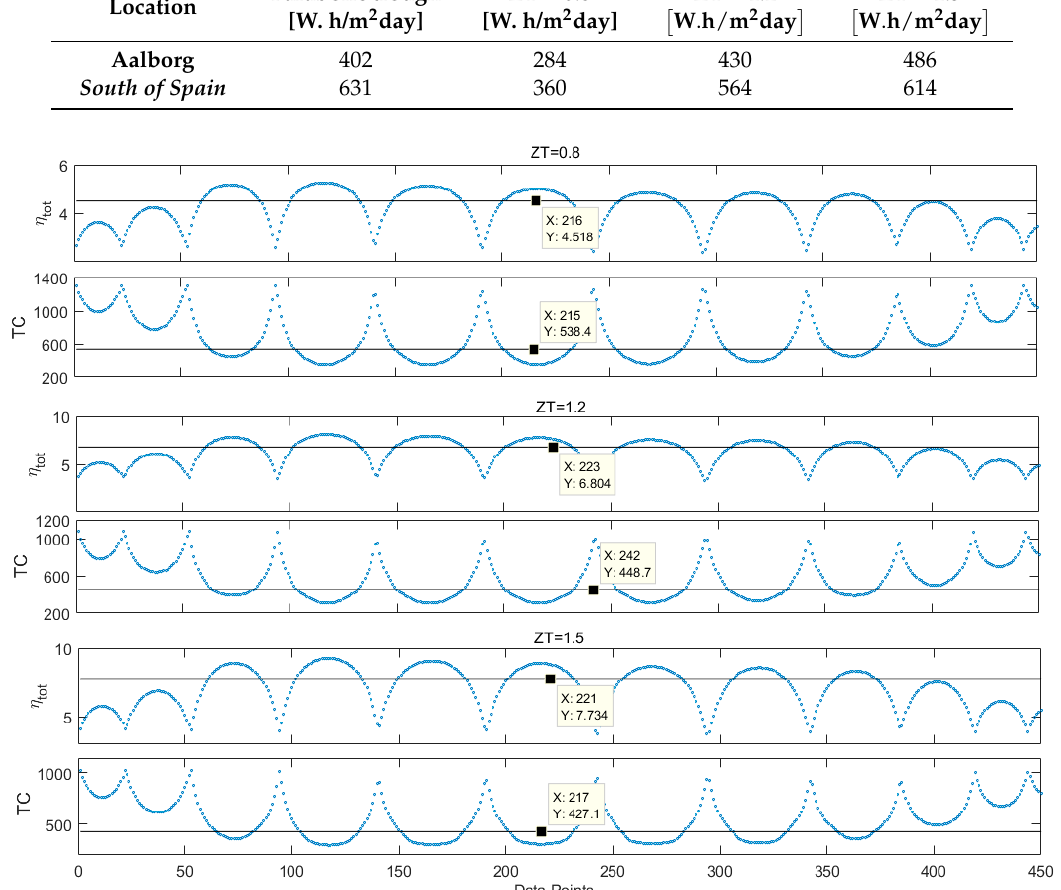
Figure 9. Maximum efficiency and optimum TC in Aalborg. Black lines are the weighted averages for each year and the blue dots are the value for each point. X axes are data points, each point represents 15 min of sunshine.